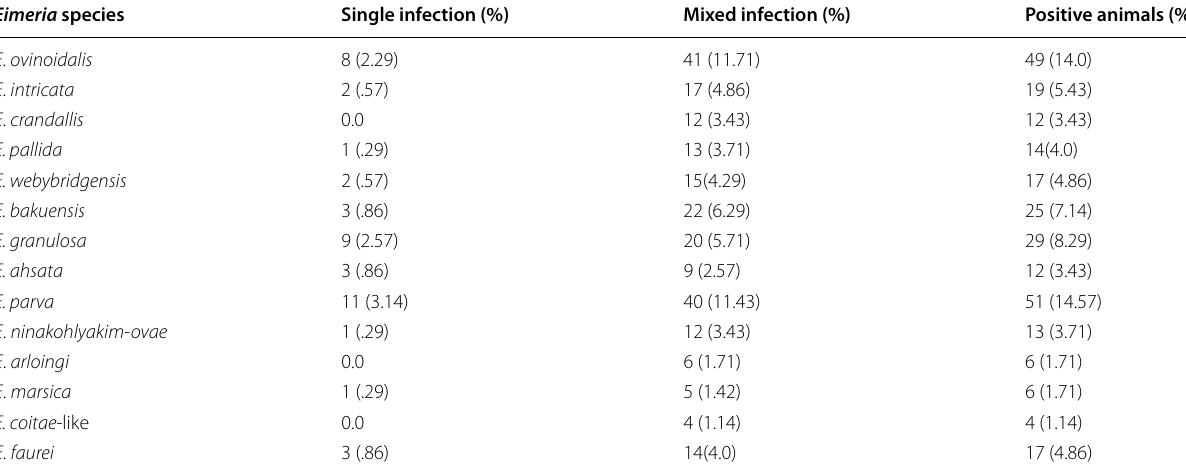
Table 3 The recovered Eimeria species in feces of the examined sheep Eimeria species Single infection (%) Mixed infection